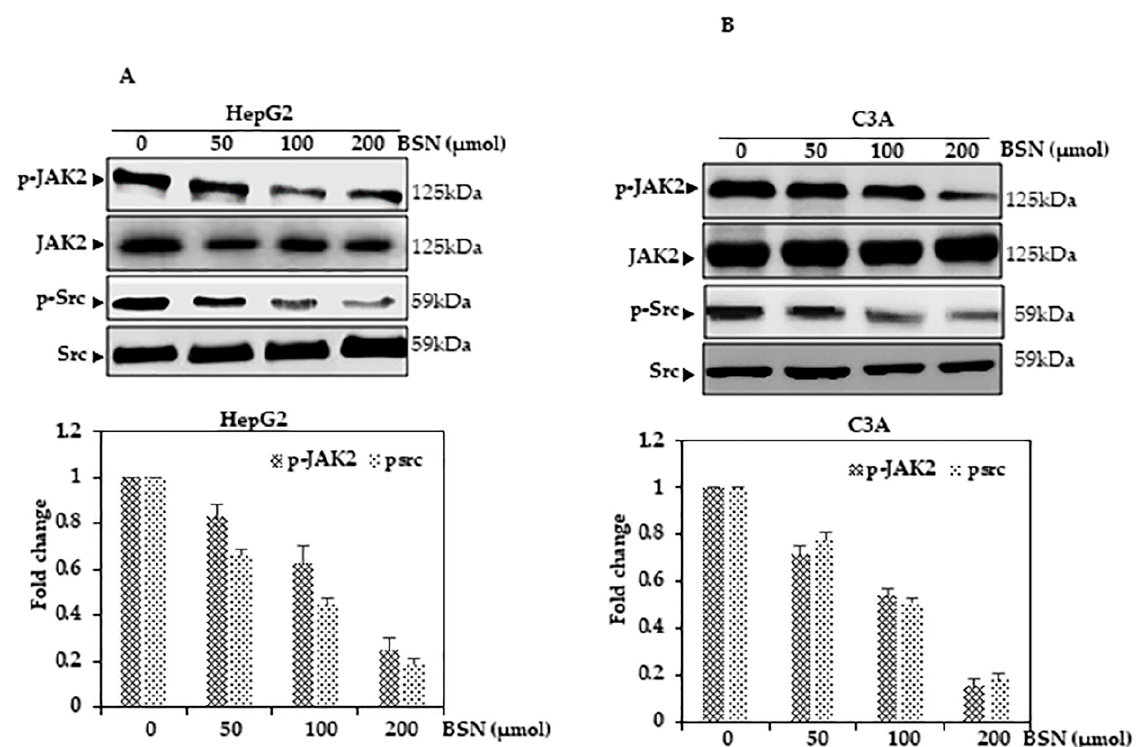
Figure 5. BSN suppressed p -JAK1, p -JAK2, and p -Src levels. ( A , B ) We treated hepG2 and C3A cells (2 × 10 6 /mL) with 0–200 µ mol BSN and then prepared whole-cell extracts and resolved 40 g aliquots on 10% SDS-PAGE. The same blots were stripped and reprobed with JAK1, JAK2, and Src antibodies for equal protein loading. Experiments were conducted in triplicate. Tukey’s post hoc test was used in this study to analyze the data. p < 0.05 was considered significant. Graph Pad prism was used. Data are presented as the mean ± SD.